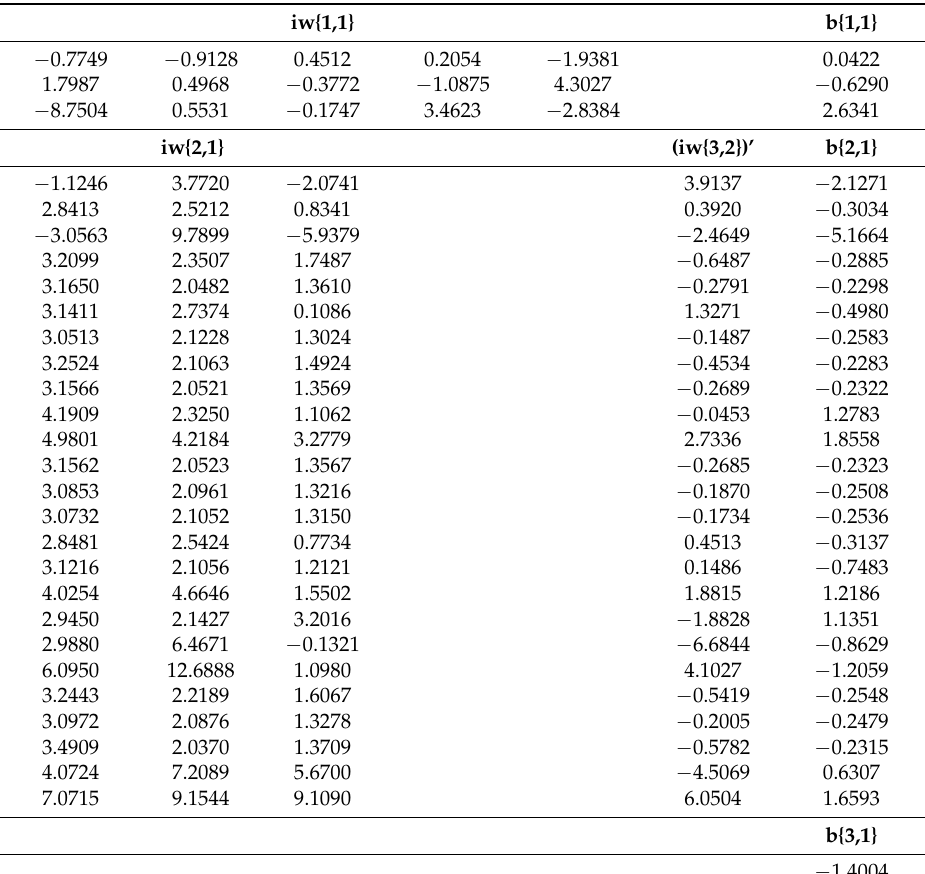
Table A2. Final Weights and Bias Values of the optimum FF-NN model 5-3-25-1 for the case of modulus of elasticity of sandcrete